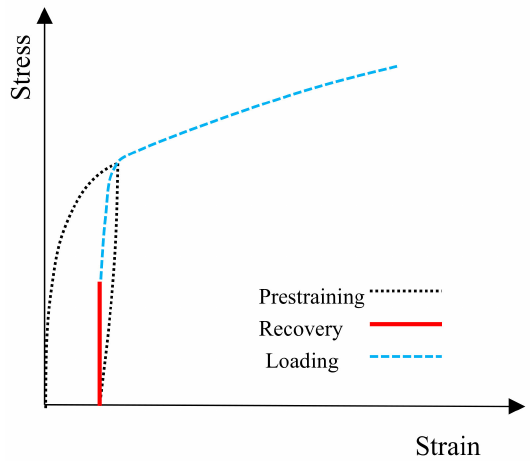
Figure 2. Stress-strain curve of activated Fe-SMA.